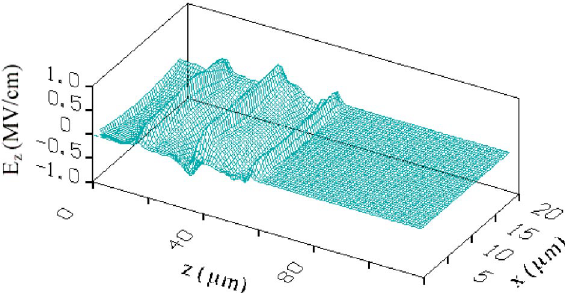
FIG. 6. (Color) Superposition of axial field E individual bunches in the z - x plane at the midplane y (cid:3) 0 at 200 fs after entry of the first bunch into the structure. The third bunch still is in the transition zone and the fields of the three bunches do not add up at the third bunch position.